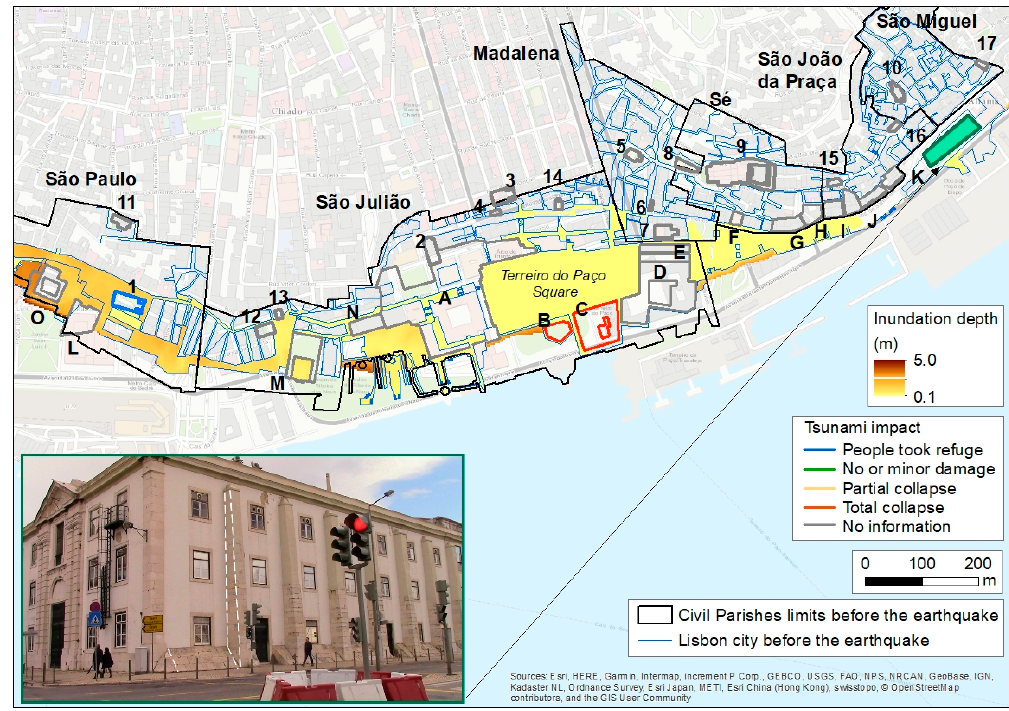
Figure 16. Numerical model results: inundation depth. Photo of the New Customs Building (Alf â